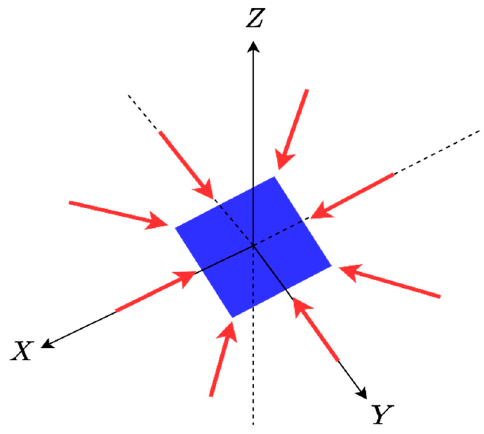
Figure 12. Comparison of the behavior of the normalized singular values for different numbers of impinging plane waves for a single XY face ID.